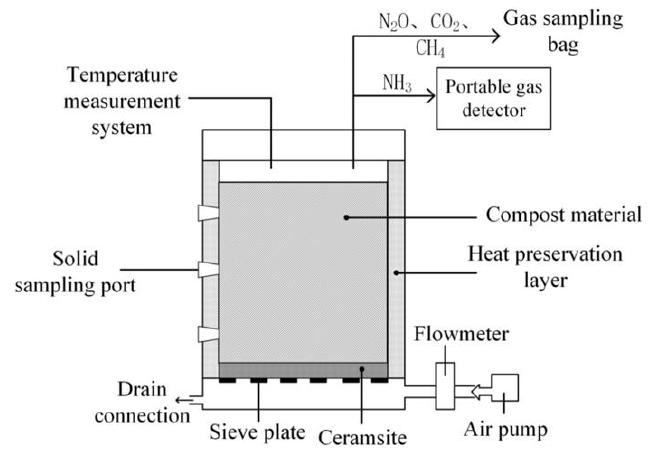
Figure 1. Schematic diagram of the composting system.